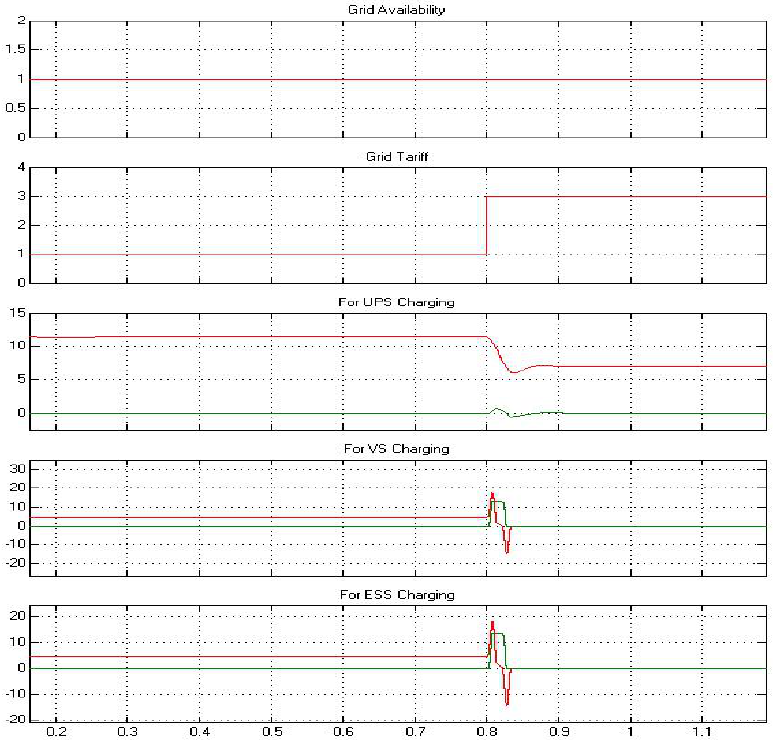
Figure 17. Simulation results for power transition in on grid mode during utility tariff change from low to high.